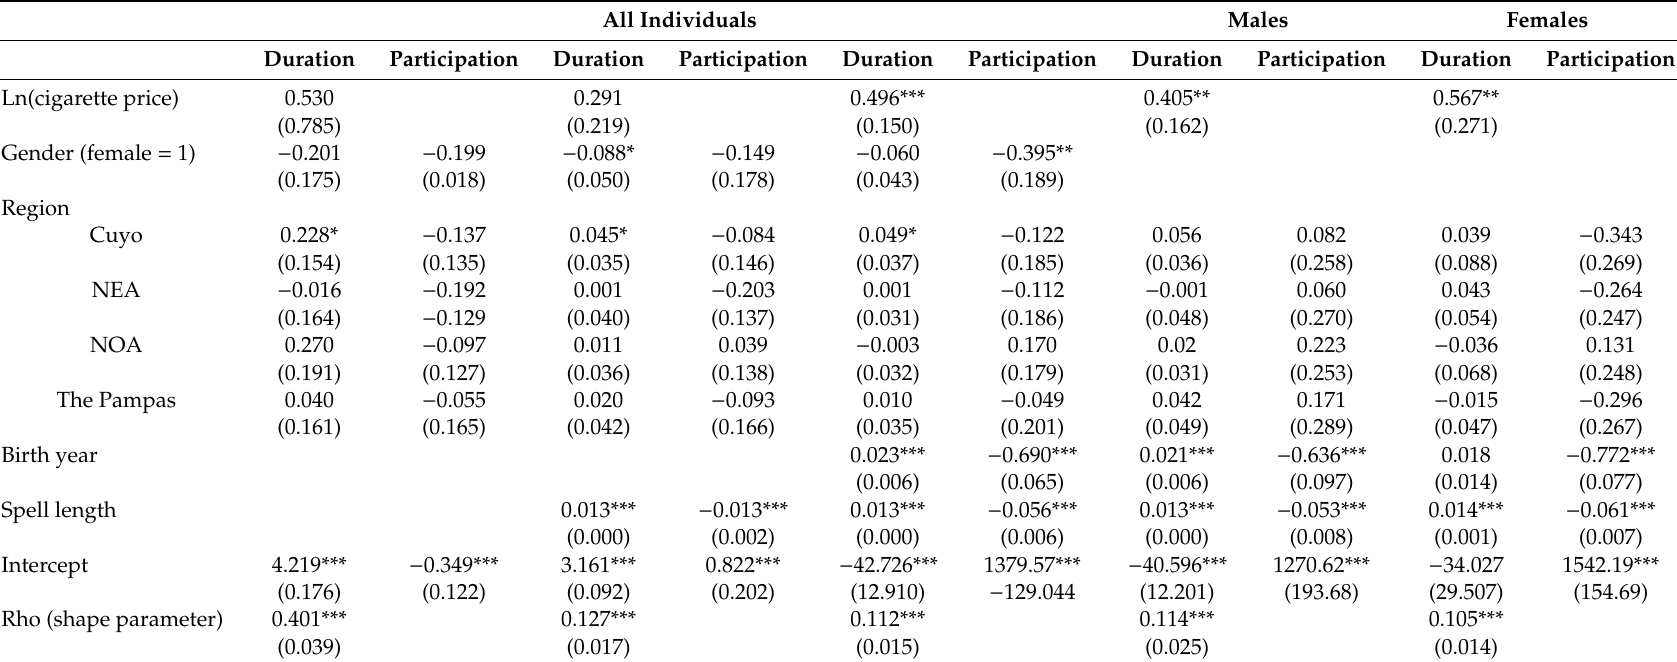
Table 1. Split-population estimations for the onset of